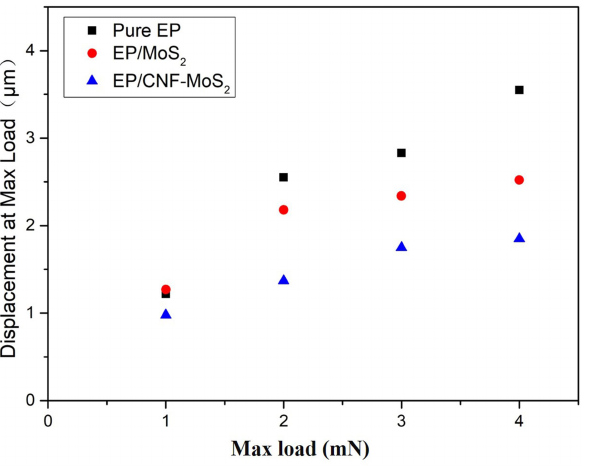
Figure 8: Variation of indentation depths at maximum load in end of the loading stage